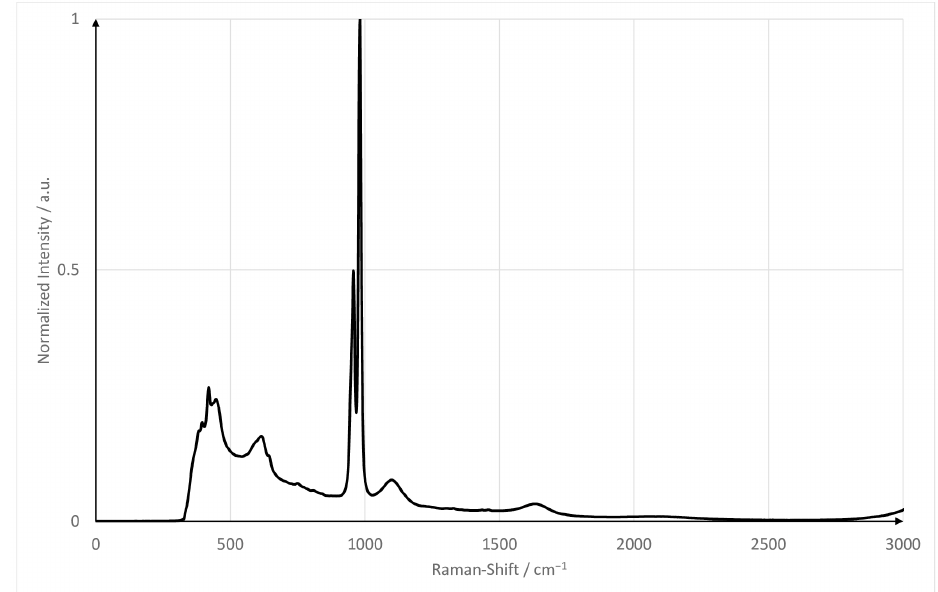
Figure 3. Raman spectrum of sodium sulfate hydrate.